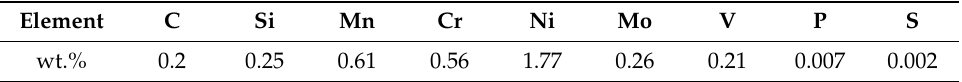
Table 1. Chemical composition of the experimental